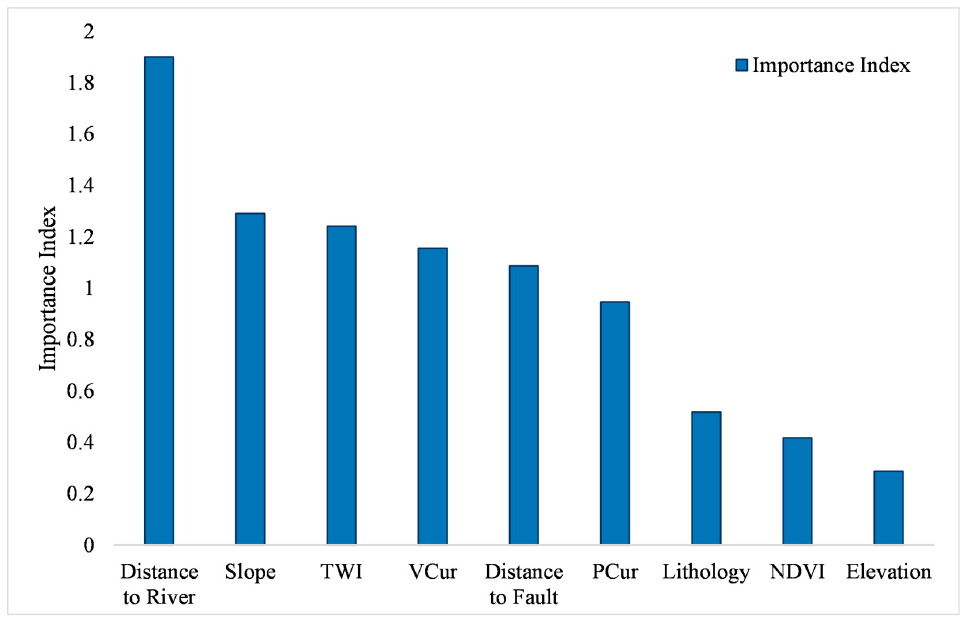
Figure 14. Relative importance assessment.